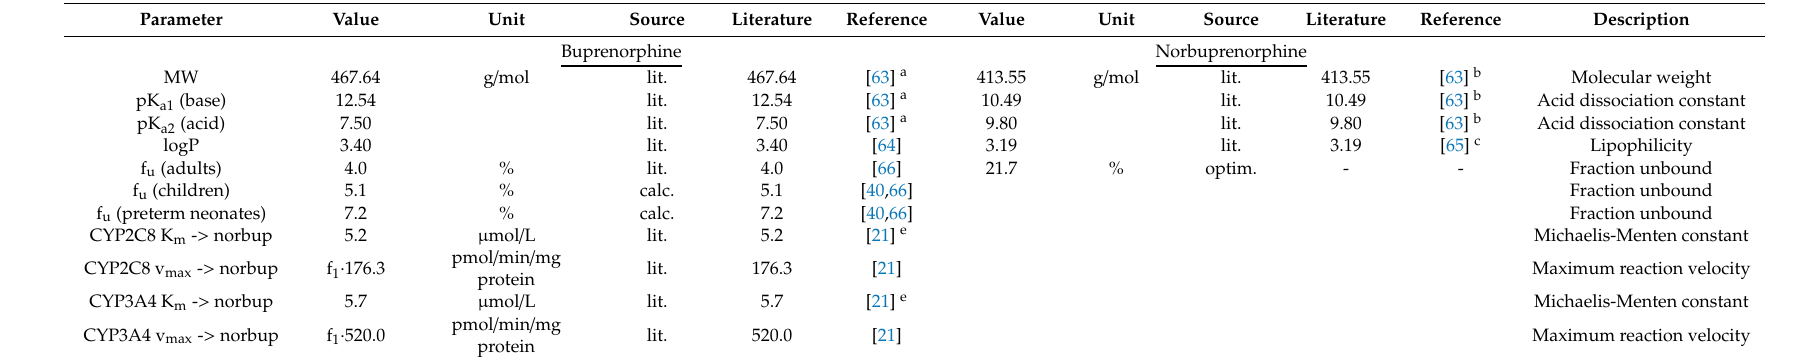
Figure 3. Predicted versus observed plasma concentrations ( a ) as well as predicted versus observed AUC last ( b ) and C max ( c ) values of buprenorphine and 1 norbuprenorphine for the adult PBPK model. In ( a ), each symbol represents a single plasma concentration (circles: buprenorphine, triangles: norbuprenorphine). In ( b , c ), each symbol represents the AUC last or C max of a single plasma concentration-time profile (blue circles: buprenorphine, green triangles: norbuprenorphine). As stated in the materials and methods section, C max values were only calculated for long-term infusions and norbuprenorphine metabolite. The black solid lines mark the lines of identity. Black dotted lines indicate 1.25-fold, black dashed lines indicate 2-fold deviation. AUC last : area under the plasma concentration-time curve from the first to the last data point, C max : maximum plasma concentration. Table 2. Buprenorphine and norbuprenorphine drug-dependent